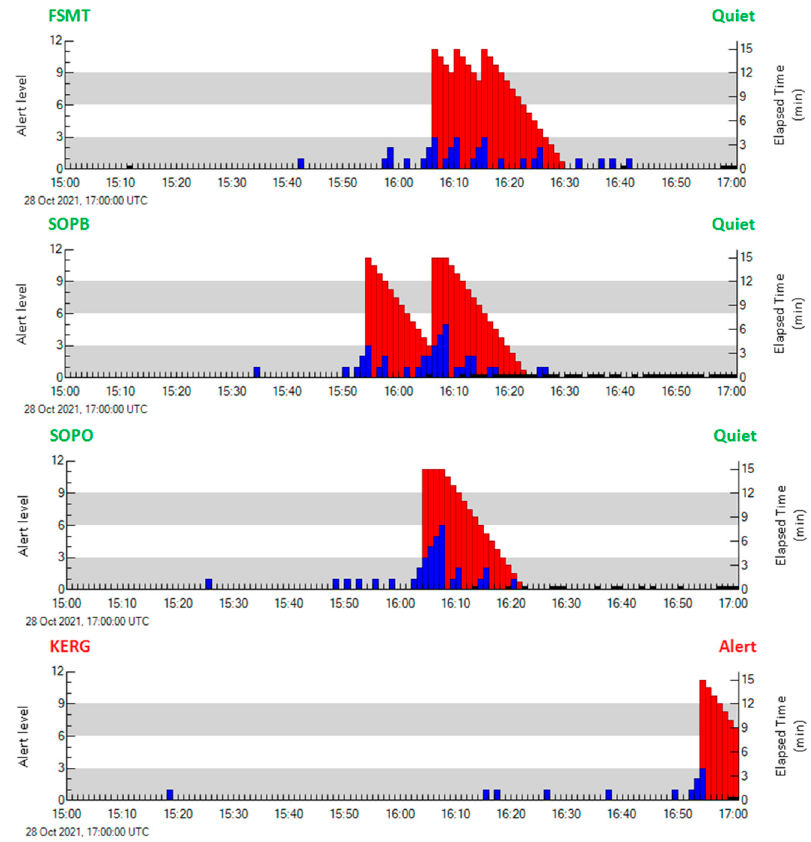
Figure 6. The evolution of the GLE Alert++ for GLE73.